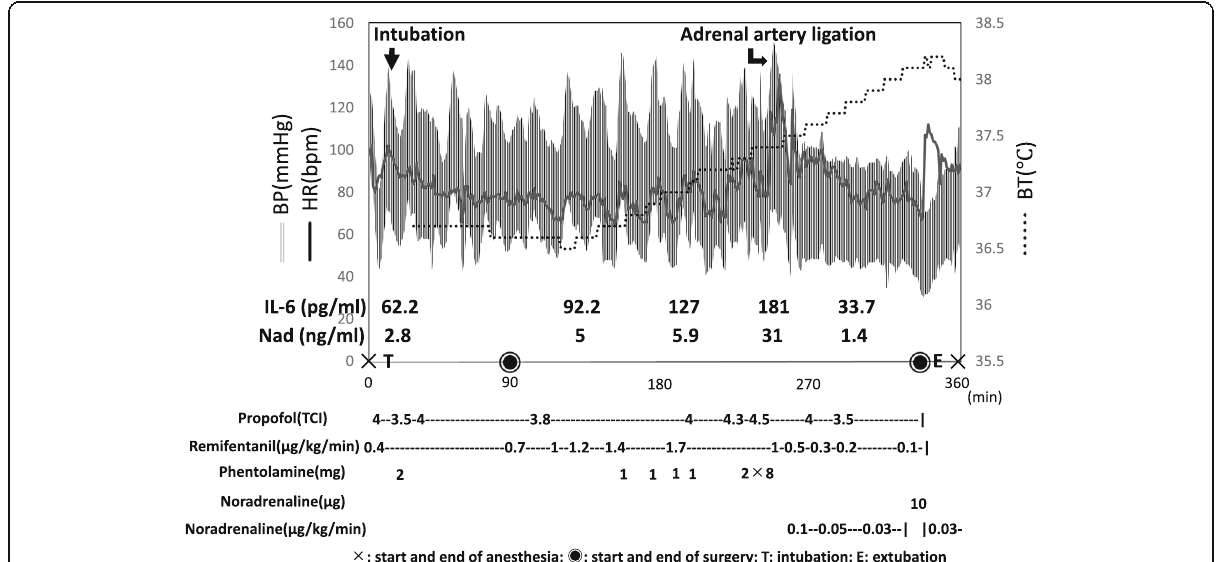
Fig. 2 Anesthesia record and serum IL-6, noradrenaline levels during surgery. BP, blood pressure; HR, heart rate; BT, body temperature. IL-6, interleukin-6; Nad,